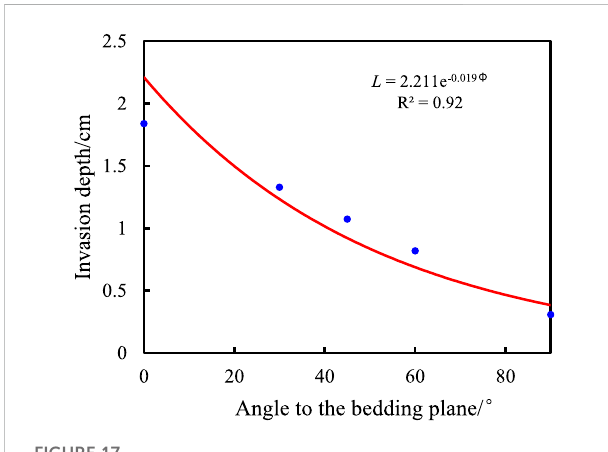
FIGURE 17 Relationship between the invasion depth of the drilling fl uid along the bedding fracture and angle to the bedding plane.